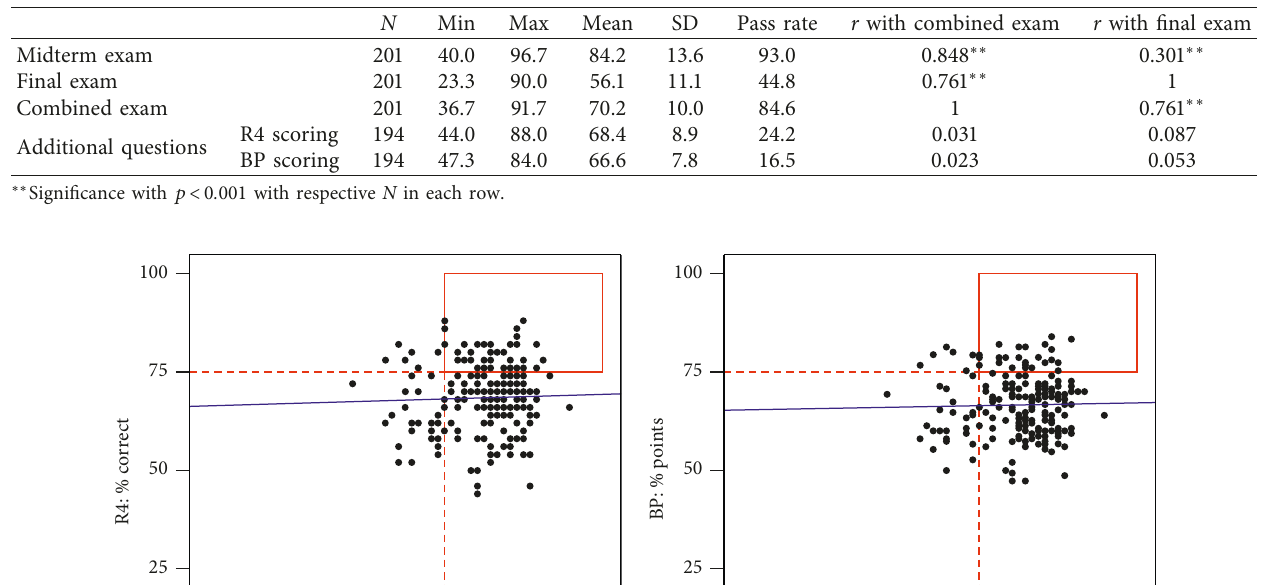
T ABLE 5: Summary of performance in the 2014 regular exams and additional questions. The values given (except N and the correlations) are the respective percentage of the maximum possible